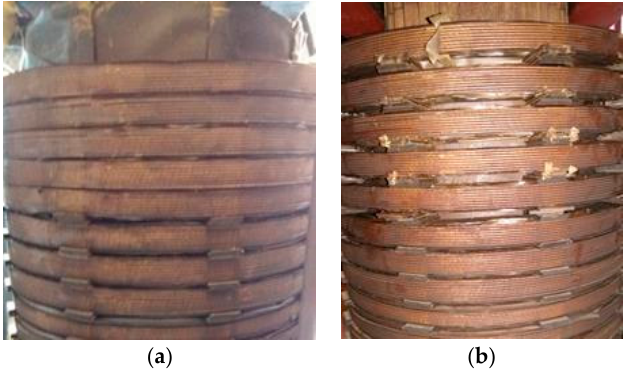
Figure 3. Deformations introduced into a winding used for calculation: ( a ) axial discs lowering (deformation 1); ( b ) axial winding expansion (deformation 2).